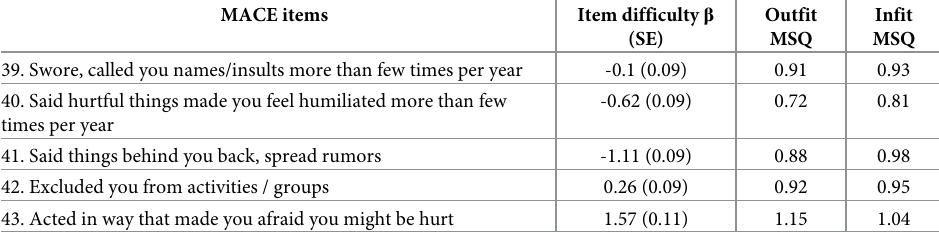
Table 4. Rasch analysis of peer emotional abuse subscale.